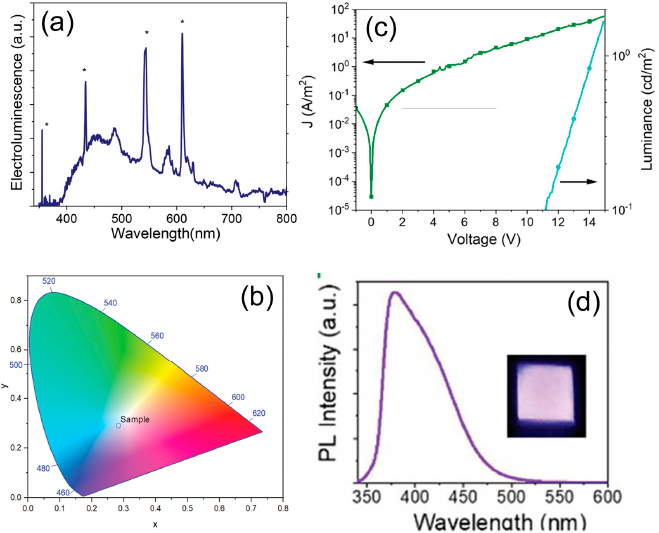
Figure 10. ( a ) The EL spectrum of CD-LED at 8 V (top); ( b ) CIE (Commission Internationale de l’Eclairage) color coordinates of LEDs with CDs as the single emitter, ( c ) J-L versus applied